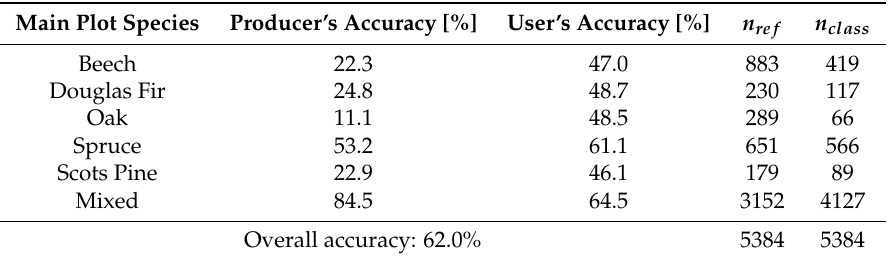
Table 3. Classification accuracies of the treespecies variable before and after calibration. n ref : number of terrestrial reference plots. n class : number of classified